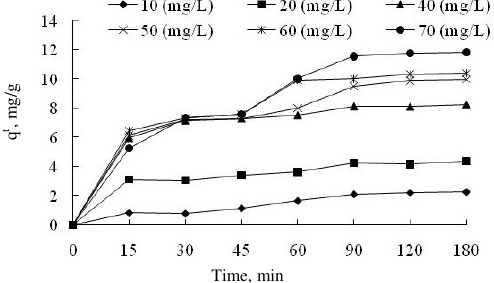
Figure 1. Effect of initial Lead ion concentration with equilibrium contact time at 30